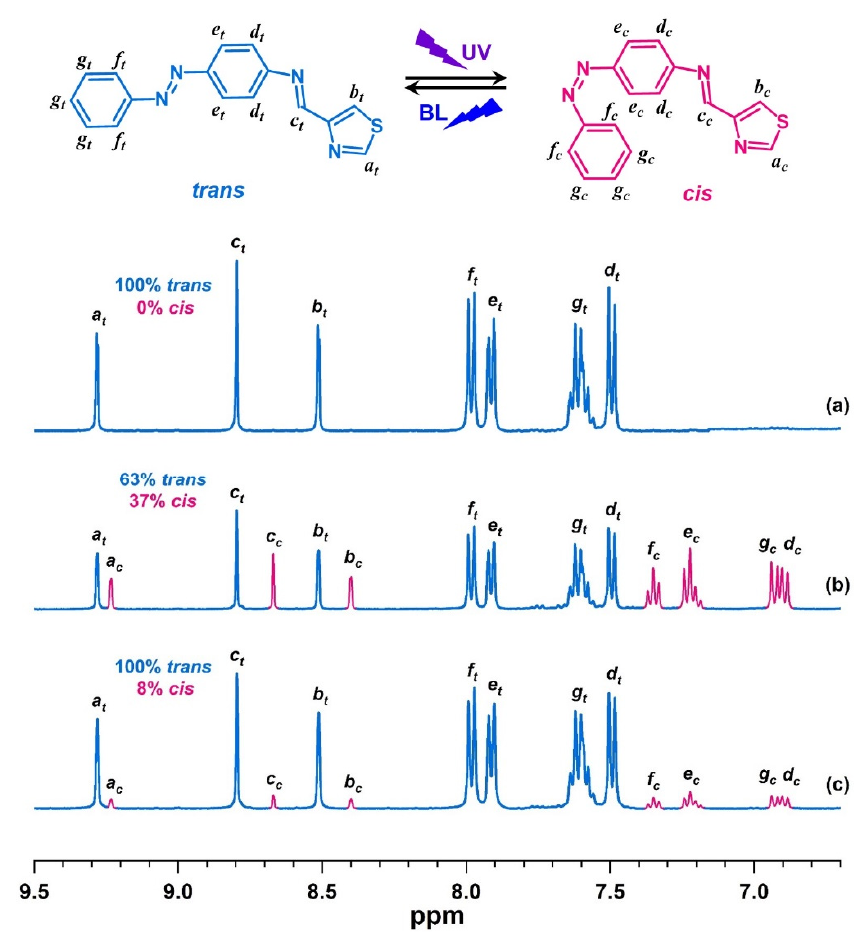
Figure 5. 1 H NMR spectra and their change of Abtz in methyl sulfoxide- d 6 were obtained ( a ) before irradiation (0% cis ); ( b ) after UV irradiation (37% cis ) and ( c ) after continuous blue-light irradiation of b (8% cis ).